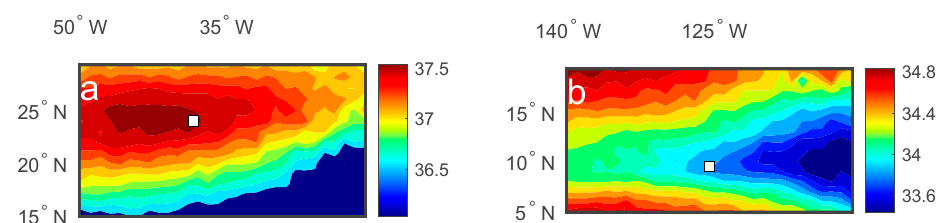
Figure 3. Mean SSS over 2011–2014 from Aquarius V5.0 monthly data, for the ( a ) SPURS-1 region in the subtropical North Atlantic, and ( b ) SPURS-2 region in the tropical eastern North Pacific. Color scale is at the right for each panel. Central mooring locations noted with a white box in each panel. The box is 1° on a side, approximately the size of the satellite footprint (Figure 2, light gray).